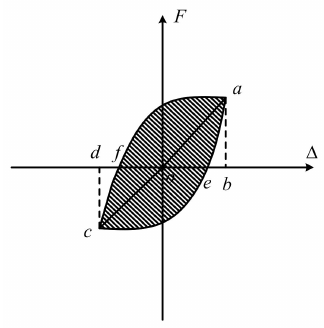
Figure 8. An illustration of hysteresis loop and energy dissipation.